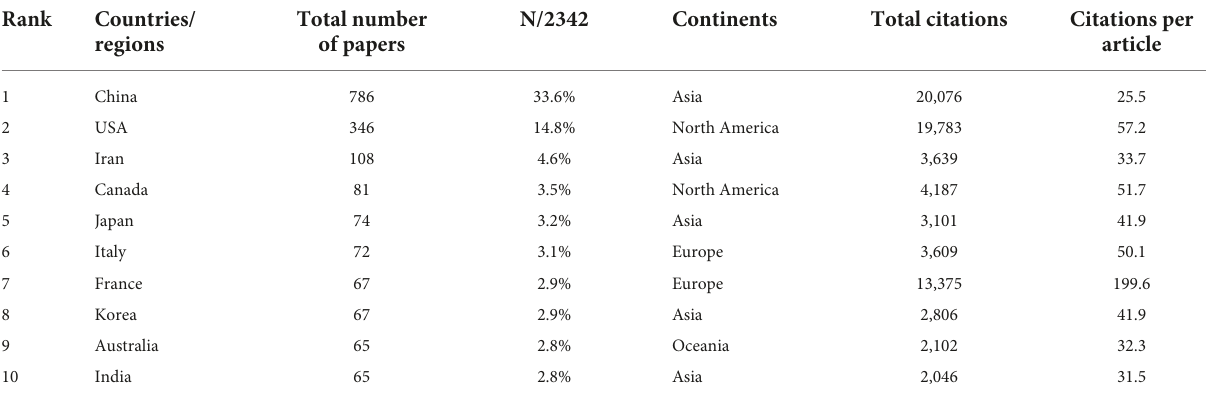
TABLE 2 Top 10 productive countries/regions related to the research field of the gut microbiota and diabetes. Rank Countries/ Total number N/2342 Continents Total citations Citations per regions of papers